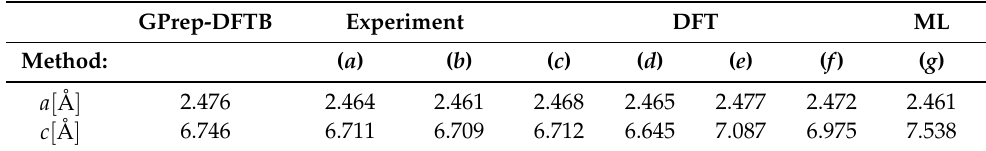
Table 1. Lattice parameters a and c of the AB -graphite unit cell, predicted using GPrep-DFTB, compared with experimental results, state-of-the-art dispersion-corrected DFT calculations, and a recently published machine learning